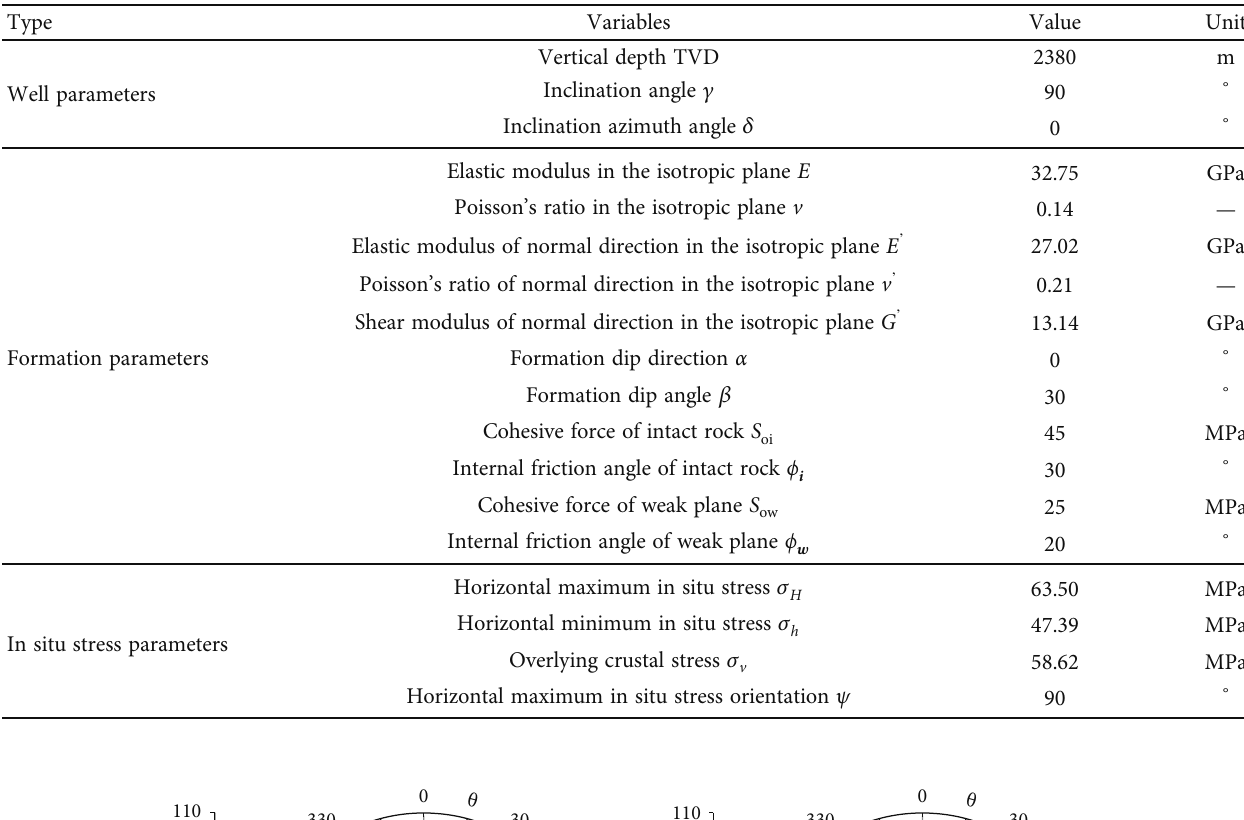
Table 2: Calculation parameters.